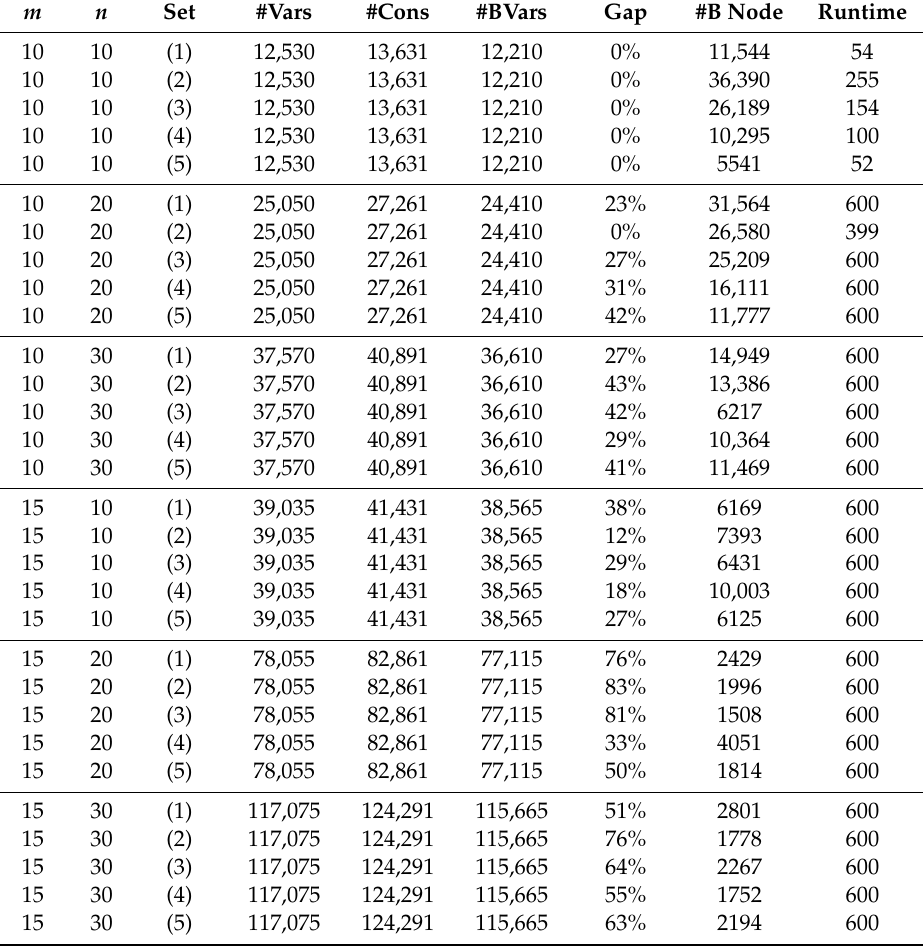
Table 3. Test results of MLOV-SM for instance group